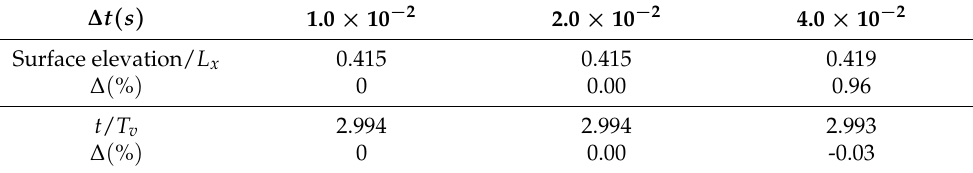
Table A13. Time step sensibility analysis for the nonlinear regime: maximum value of surface elevation/ L x , its time location t / T v , and their relative difference compared to ∆ t ( s ) = 1.0 × 10 − 2 s for VOF S .